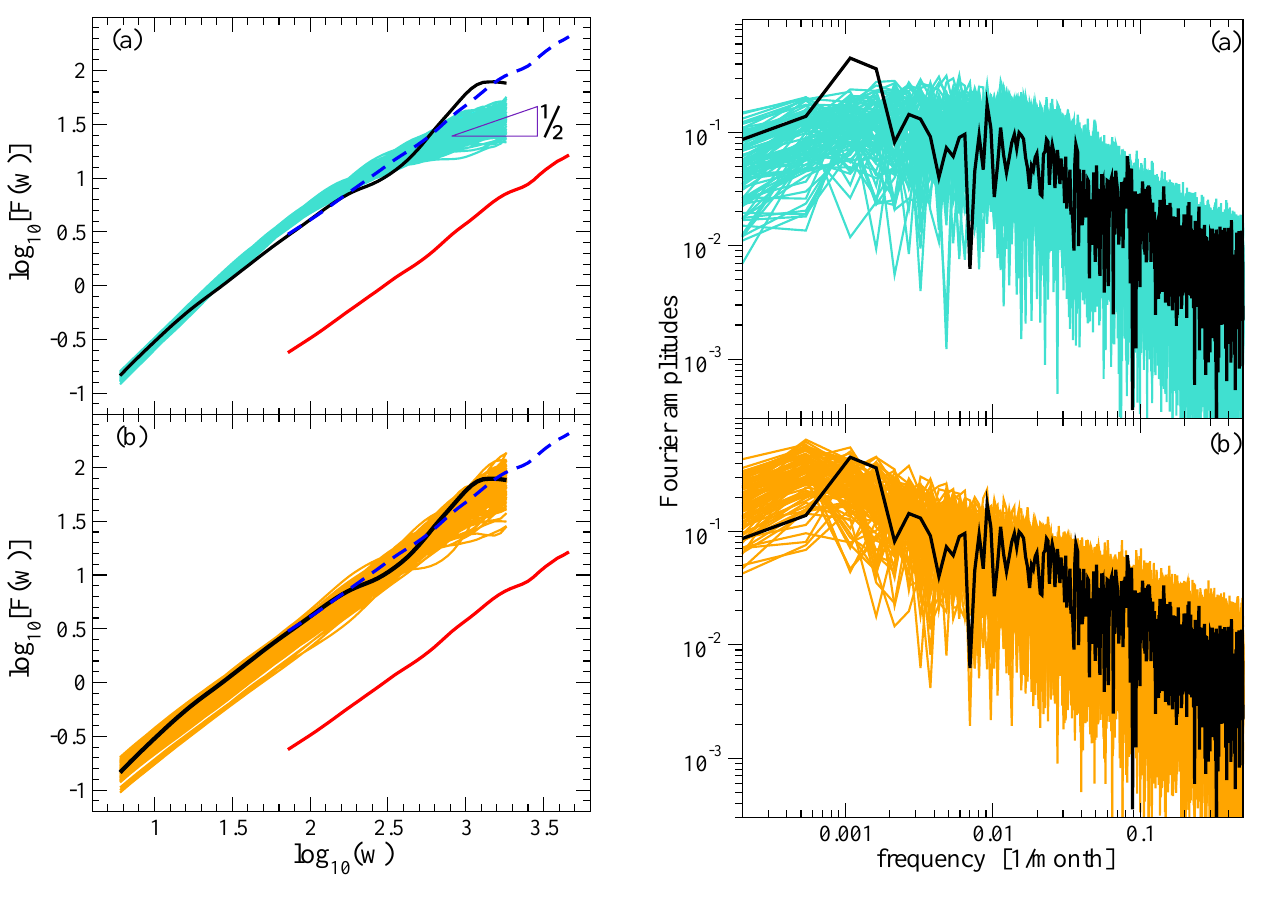
Fig. 4. The logarithm of DFA2 fluctuations log 10 [ F(w) ] as a func- tion of the logarithm of sliding window size log 10 (w) for the model sequences (thin coloured lines) and for the monthly mean SST anomaly (thick black curve). The thick red line is the same for the tree ring proxy annual mean SST (see Fig. 2), also shown as a blue dashed line shifted upward. (a) Fitted AR(1) model series, and (b) long range correlated series with β = 0 . 6.